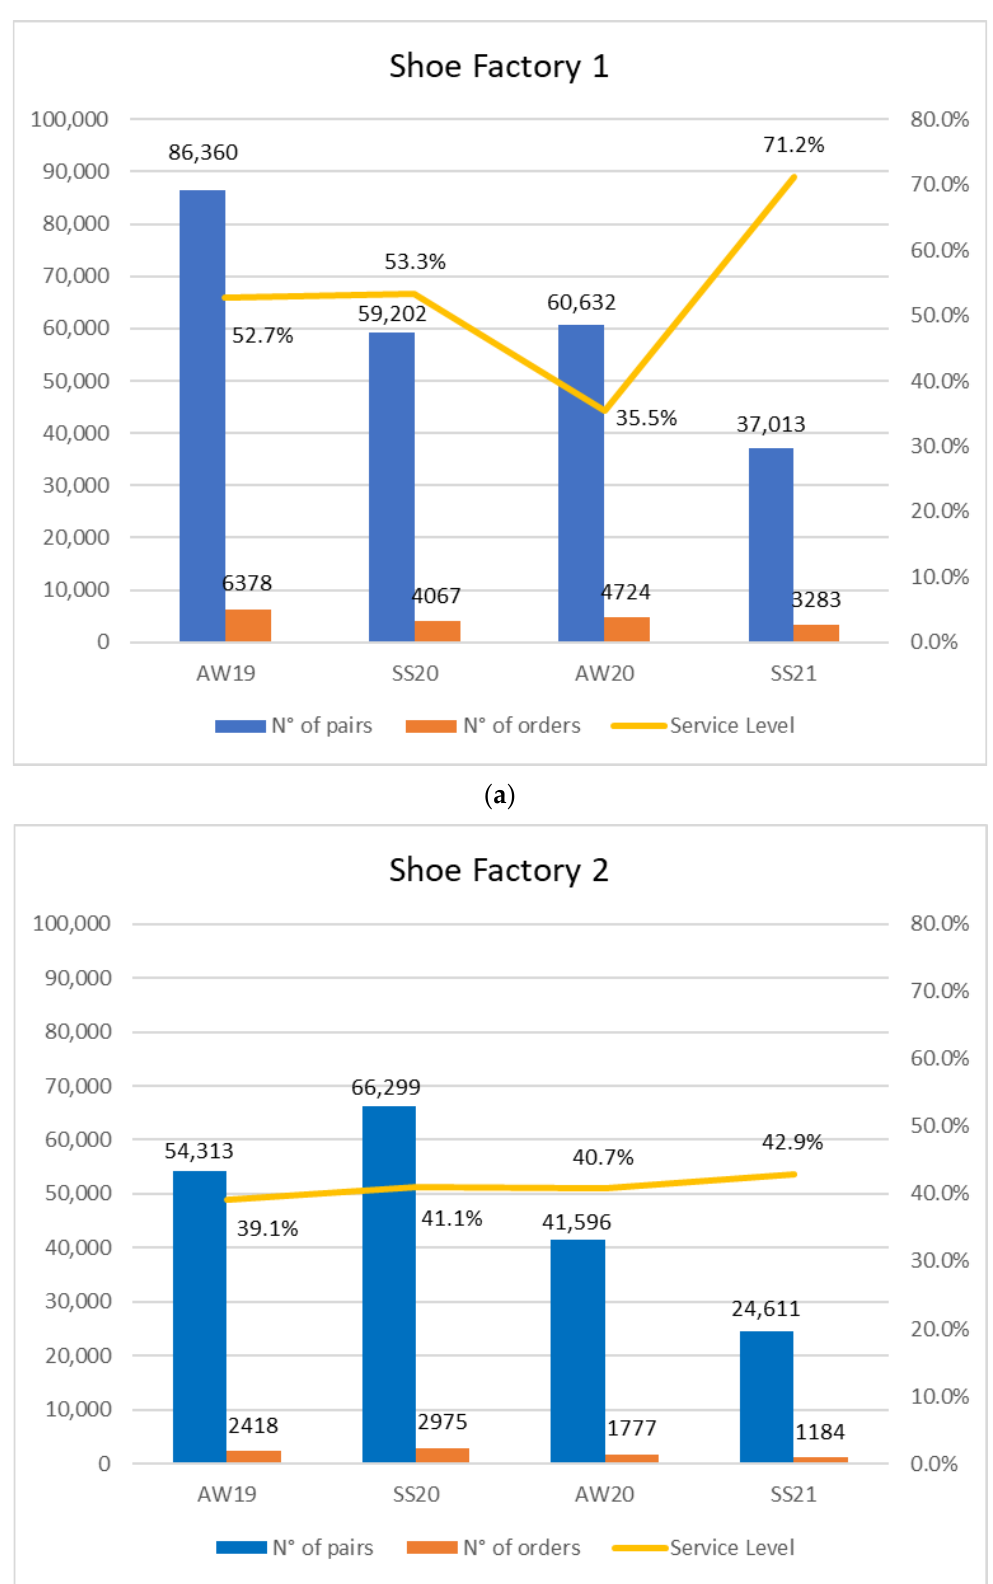
Figure 5. Shoe factories — seasonal N° of pairs, N° of orders, and Service Level of SF1 ( a ) and SF2 ( b ).